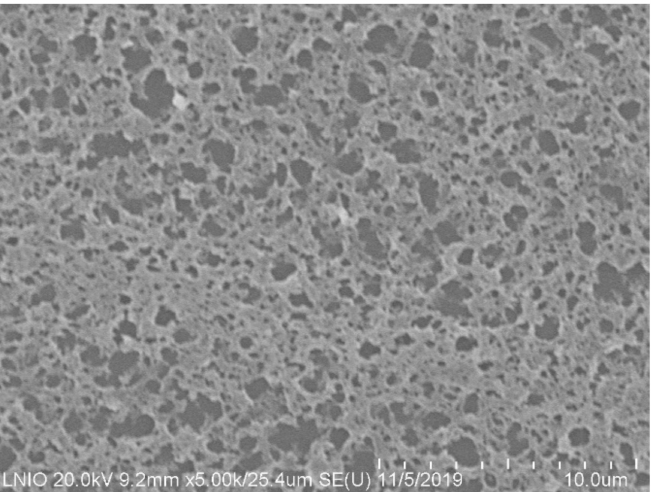
Figure A2. SEM image showing the non-continuous structure of the PMMA/acetone layer.